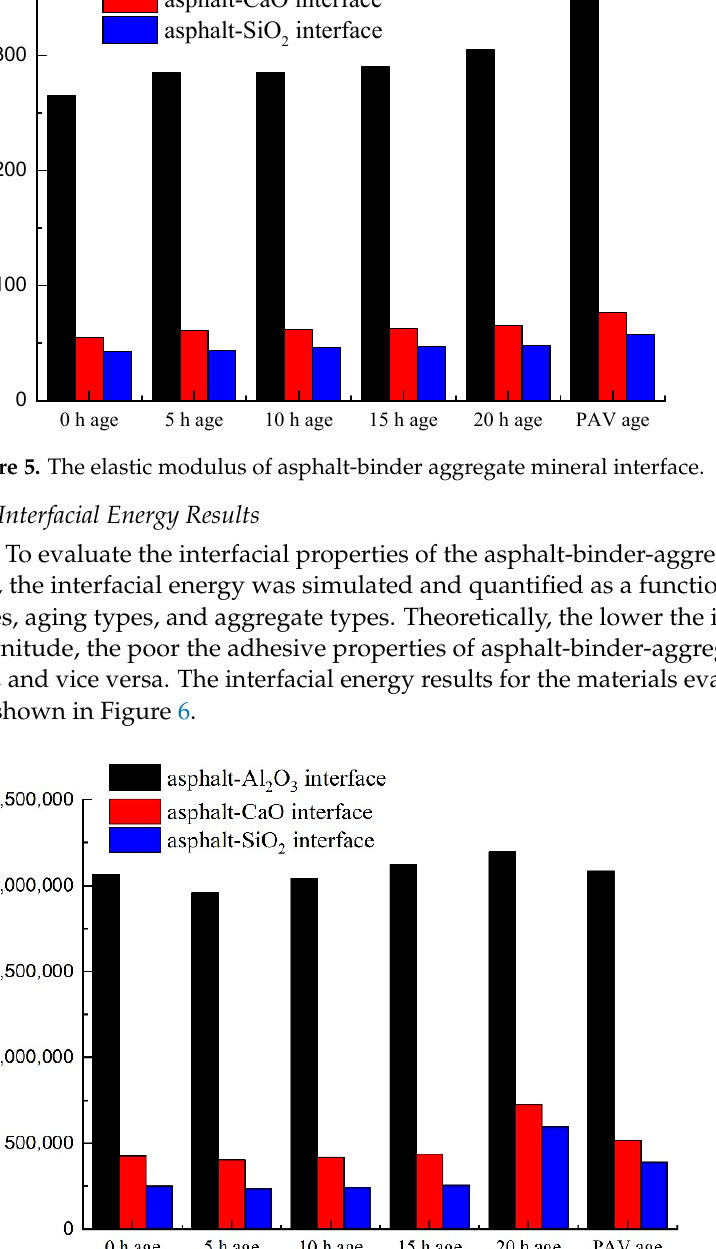
Figure 5. The elastic modulus of asphalt-binder aggregate mineral interface.